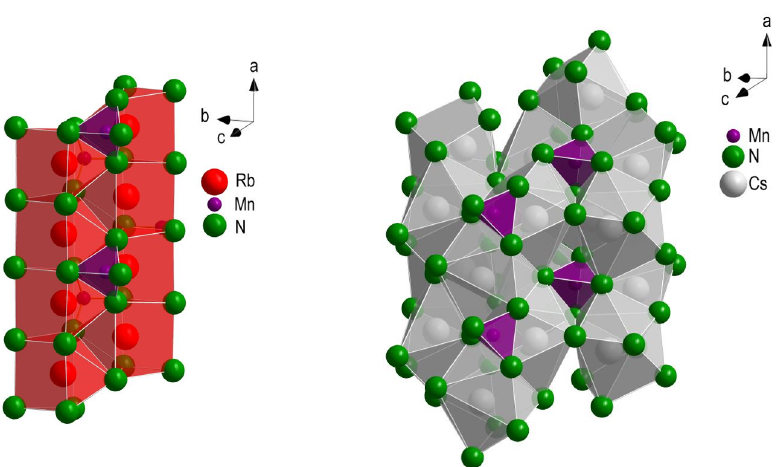
Figure 3. Interconnection of polyhedra surrounding the alkali metal ions in HT-Rb 2 [Mn(NH 2 ) 4 ] ( left ) and Cs 2 [Mn(NH 2 ) 4 ] ( right